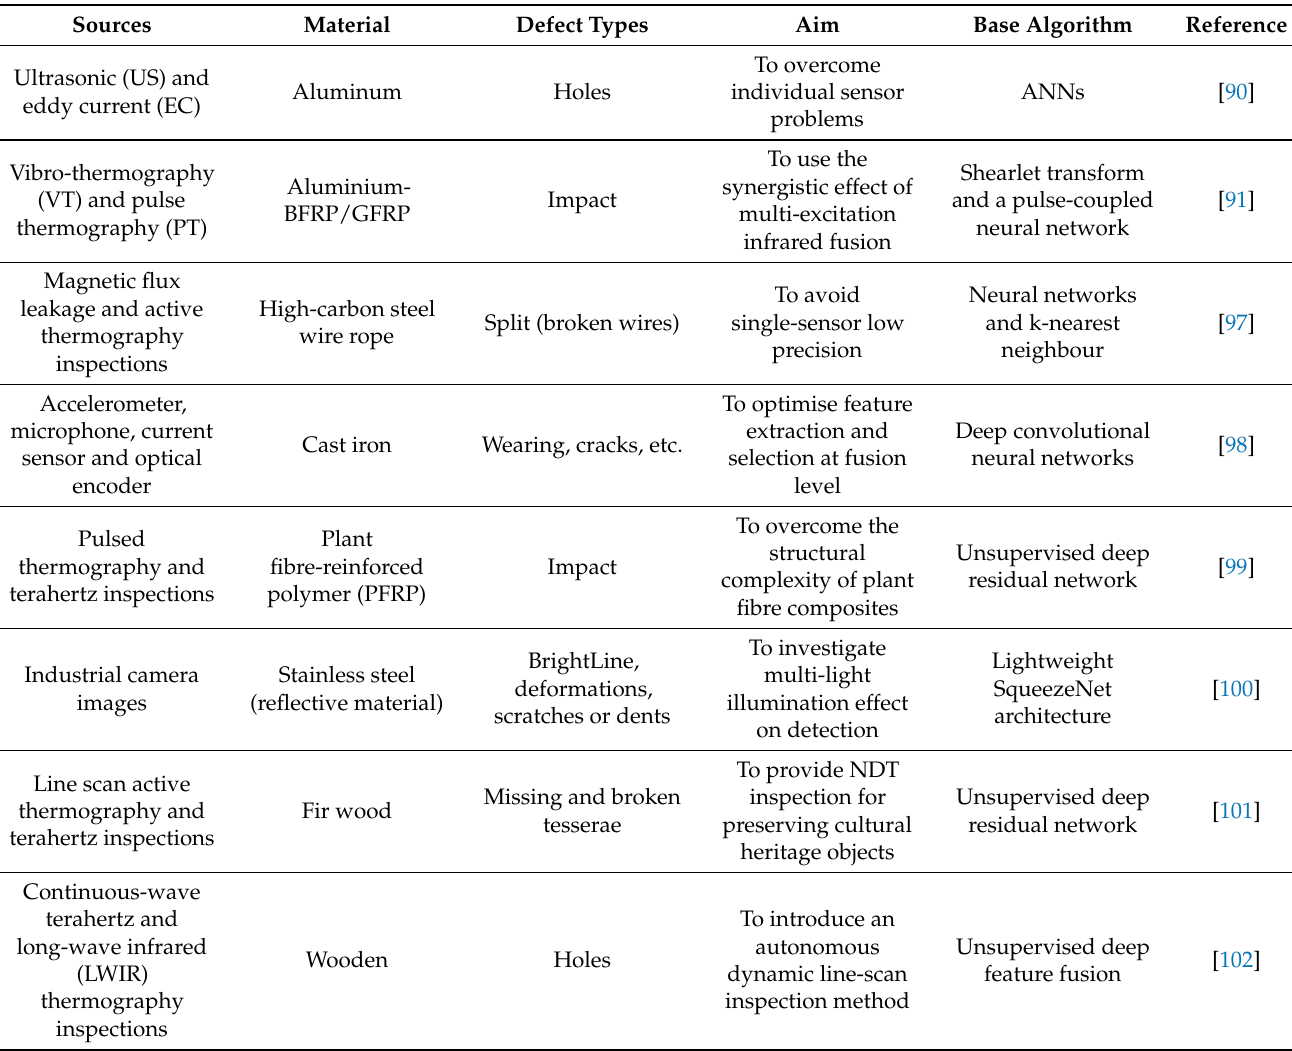
Table 6. A summary of the recent neural network-based fusion studies for NDT